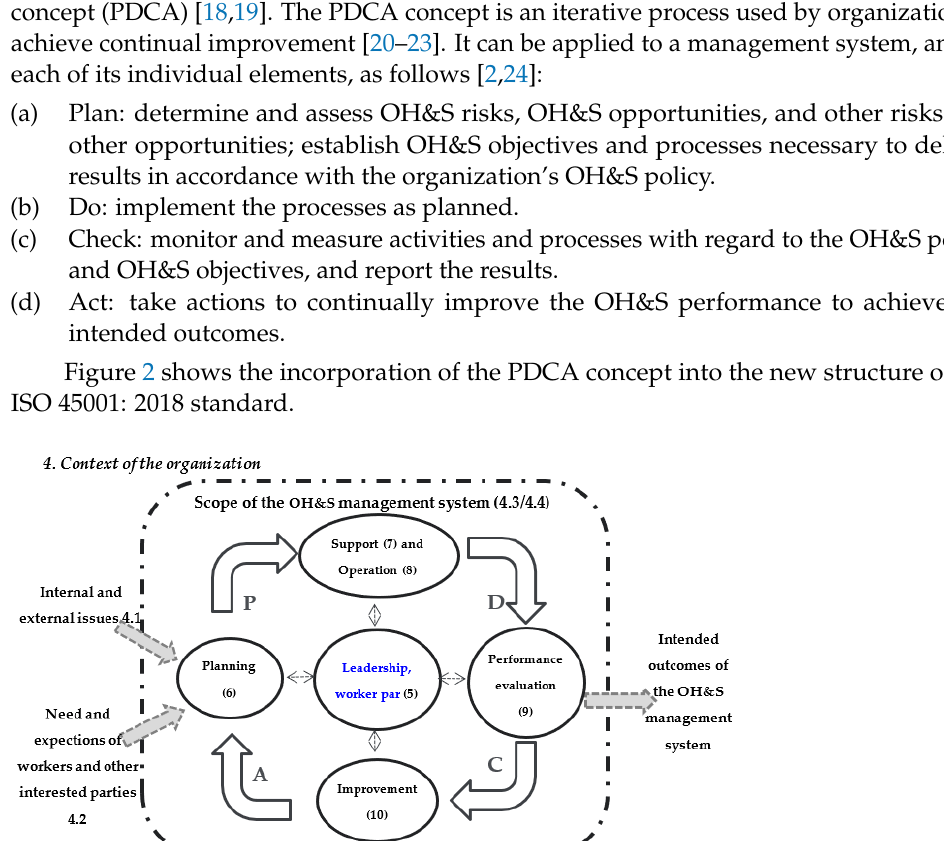
Figure 3. The structure of the OH&S according to ISO 45001 from the point of view of PDCA [25].